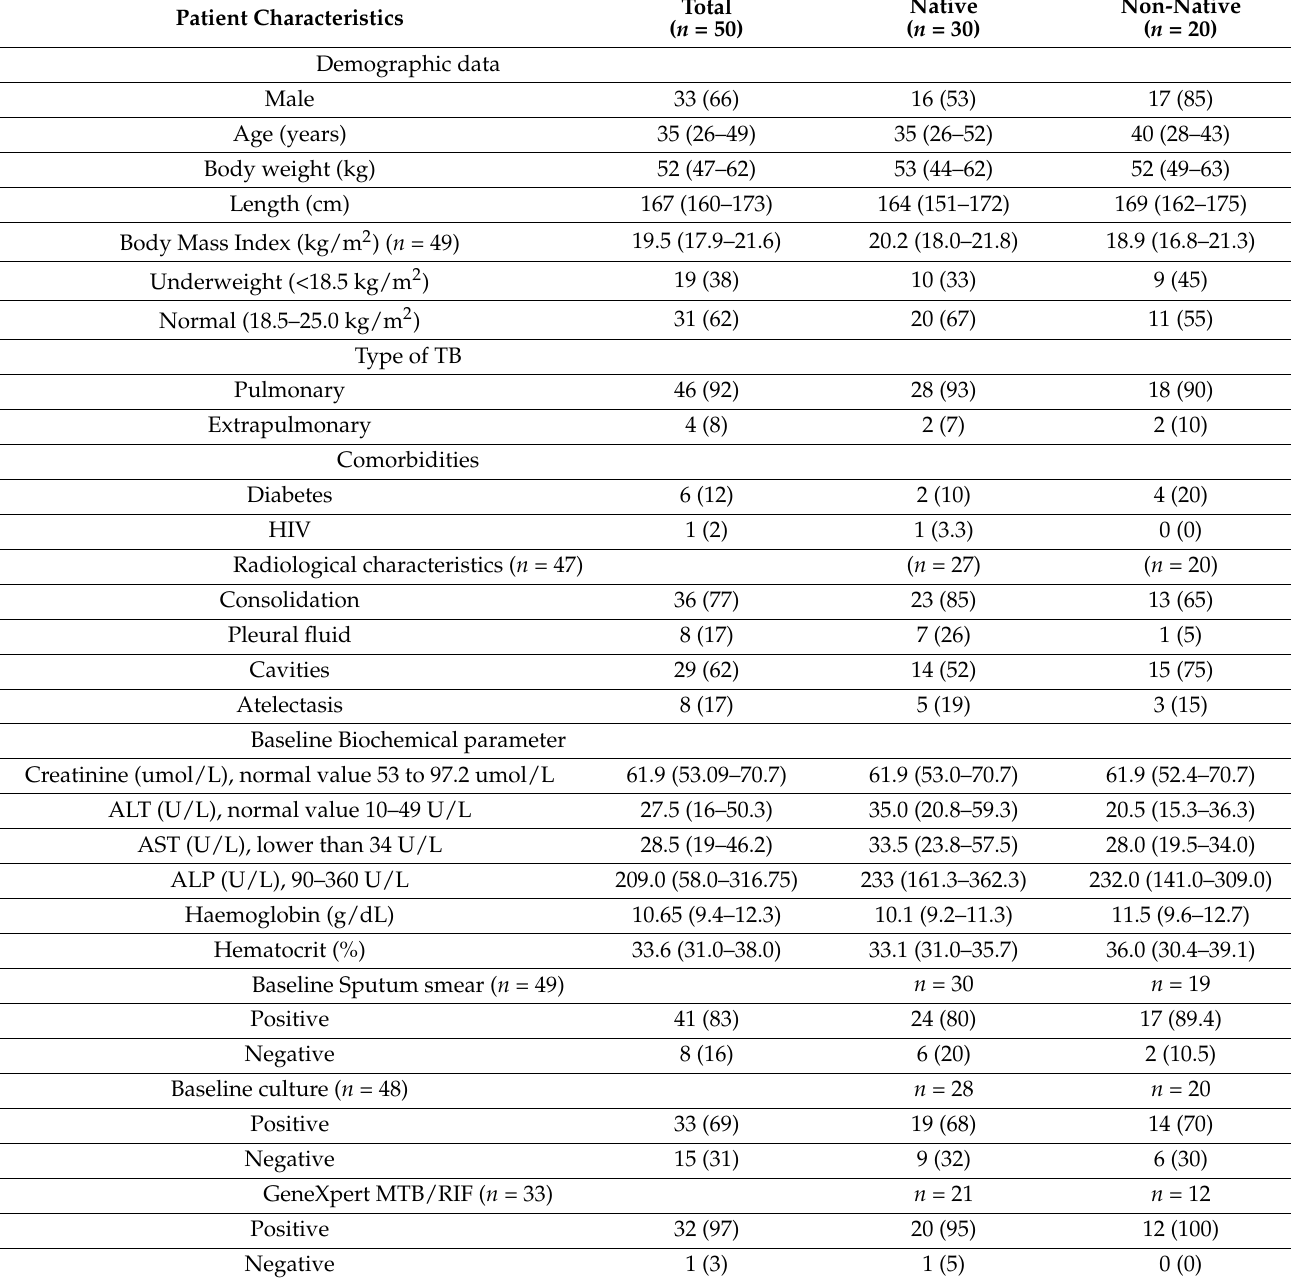
Table 1. Baseline characteristics of all included